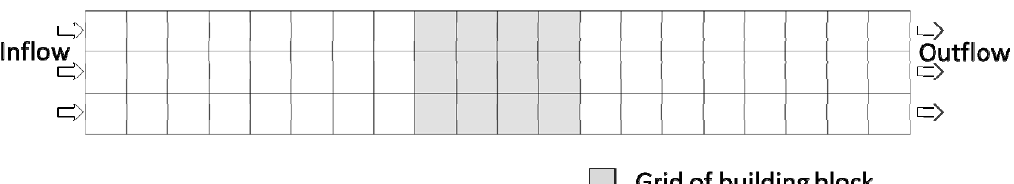
Figure 8. Simulation grid of 2D inundation model in experiment scale.